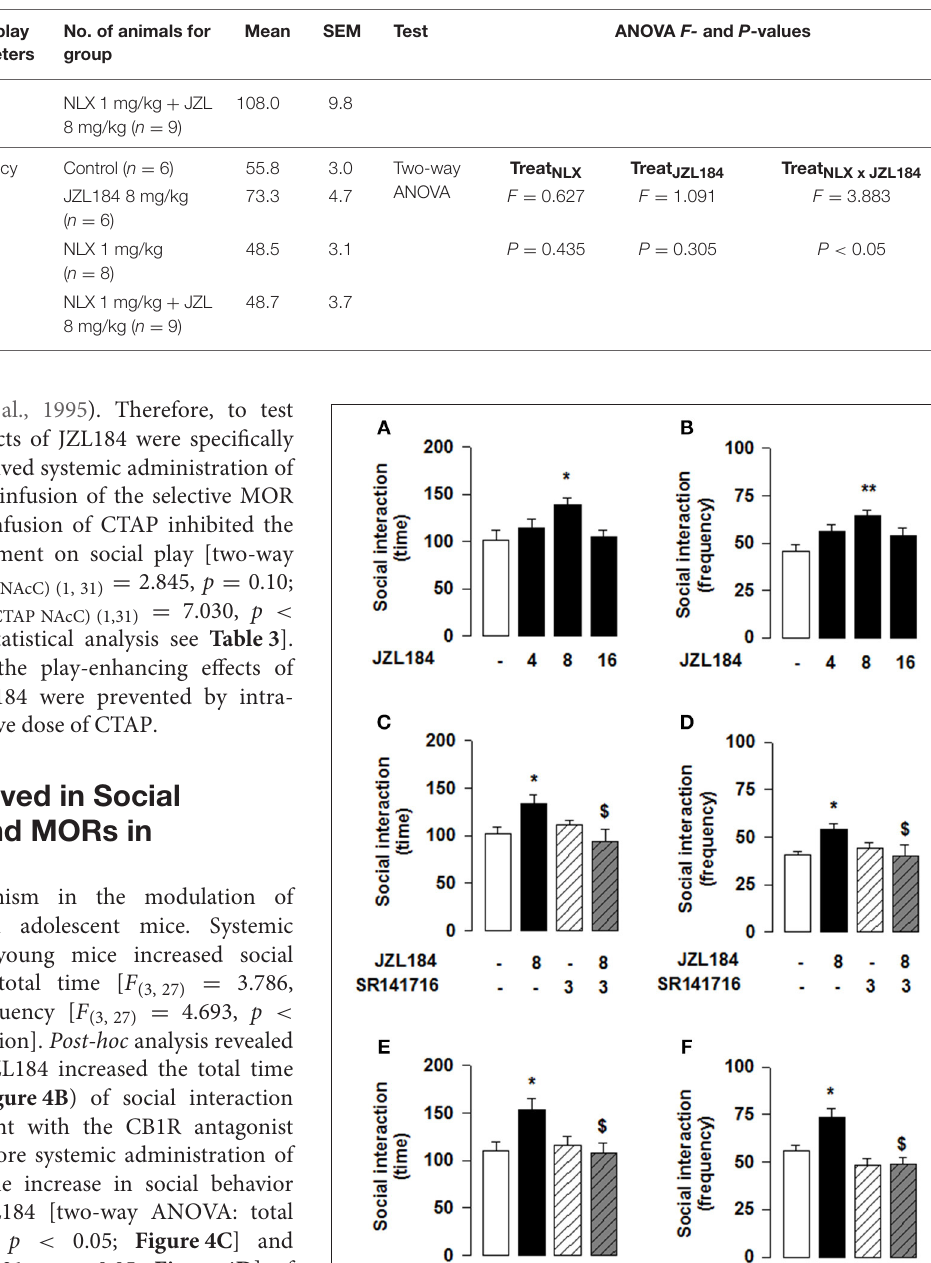
naloxone. This interaction was bidirectional since the social